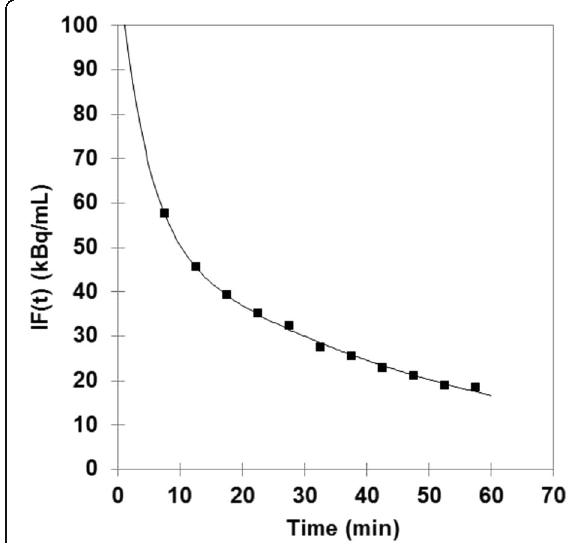
Fig. 1 Typical IF fitting (patient 9 in Table 1; R = 0.989; P < 0.001). PET data (square) are uncorrected for 18 F physical